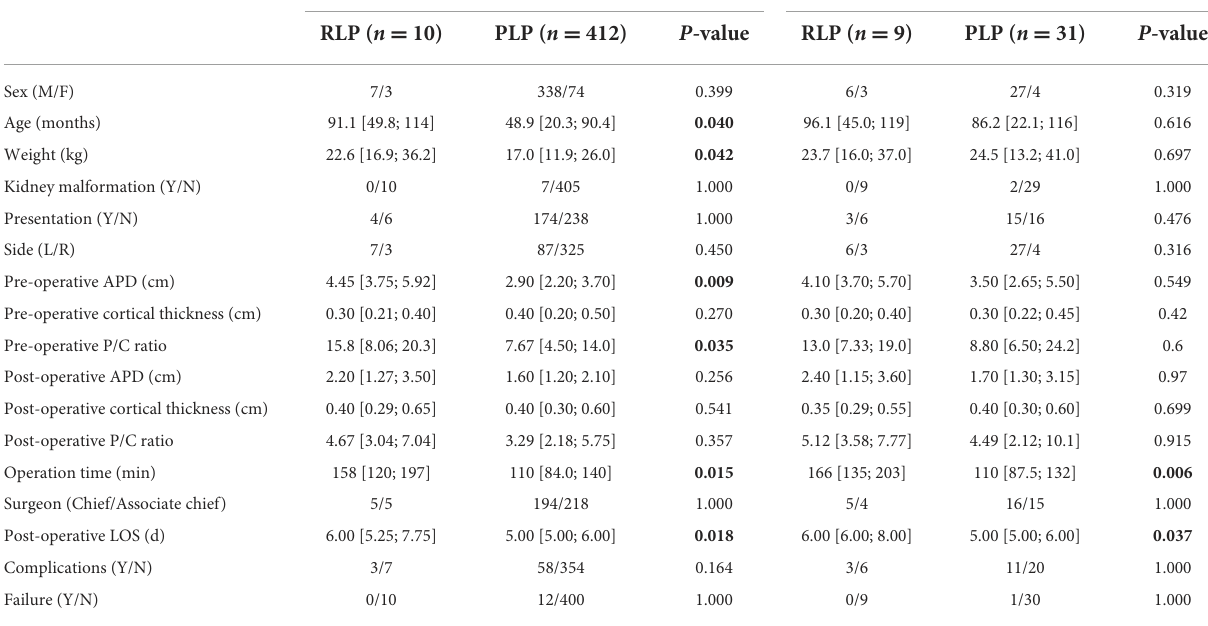
TABLE 2 Characteristics for patients underwent primary and redo laparoscopic